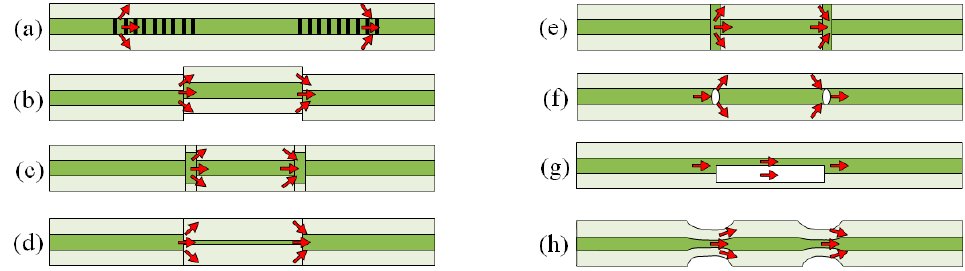
Figure 8. Configurations for in-line Mach-Zehnder interferometers: ( a ) A pair of LPFGs; ( b ) core-offset; ( c ) core diameter mismatch with larger core fiber; ( d ) core diameter mismatch with smaller core fiber; ( e ) air-hole collapsing of PCF; ( f ) cavities formed in core by femtosecond laser; ( g ) cavity formed at core-cladding interface by femtosecond laser; ( h ) fiber tapering.